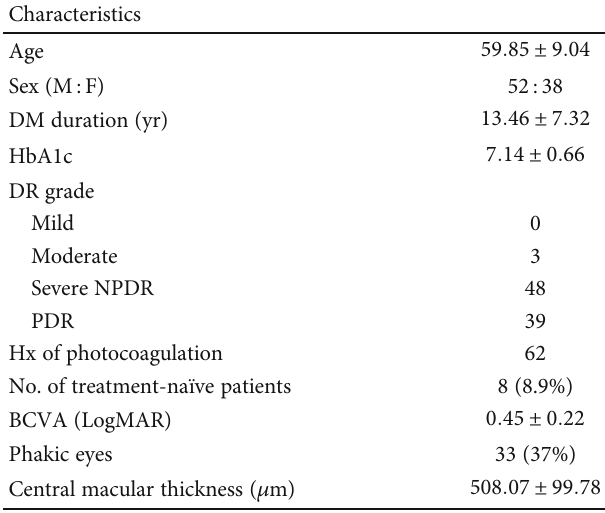
Table 1: Baseline characteristics of the diabetic macular edema study